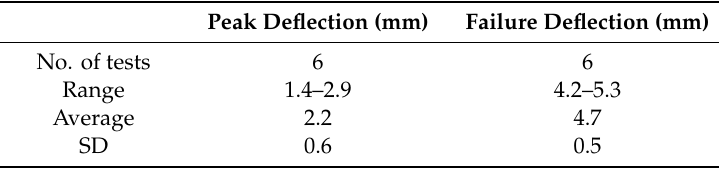
Table 13. Deflection average value and standard deviation.